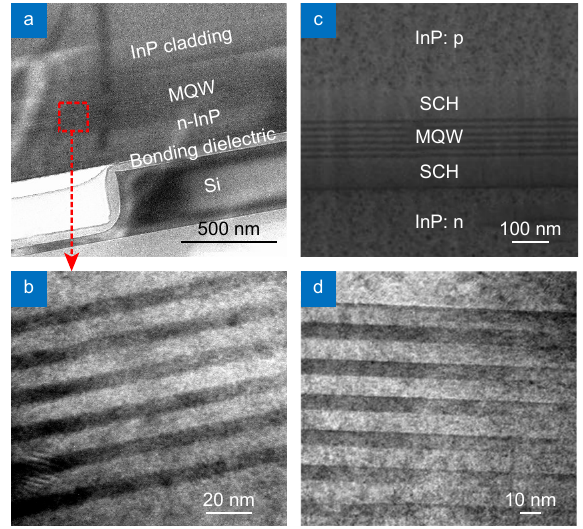
Fig. 5 | Cross-sectional TEM (or STEM) images of the MQW or bulk epitaxy on the bonded substrate from HPE and III-V Lab. Figure repoduced with permisson from: (a, b) ref. 29 , under a Creative Commons Attribution 4.0 International License; (c) ref. 32 , IEEE; (d) ref. 31 , John Wiley and Sons.